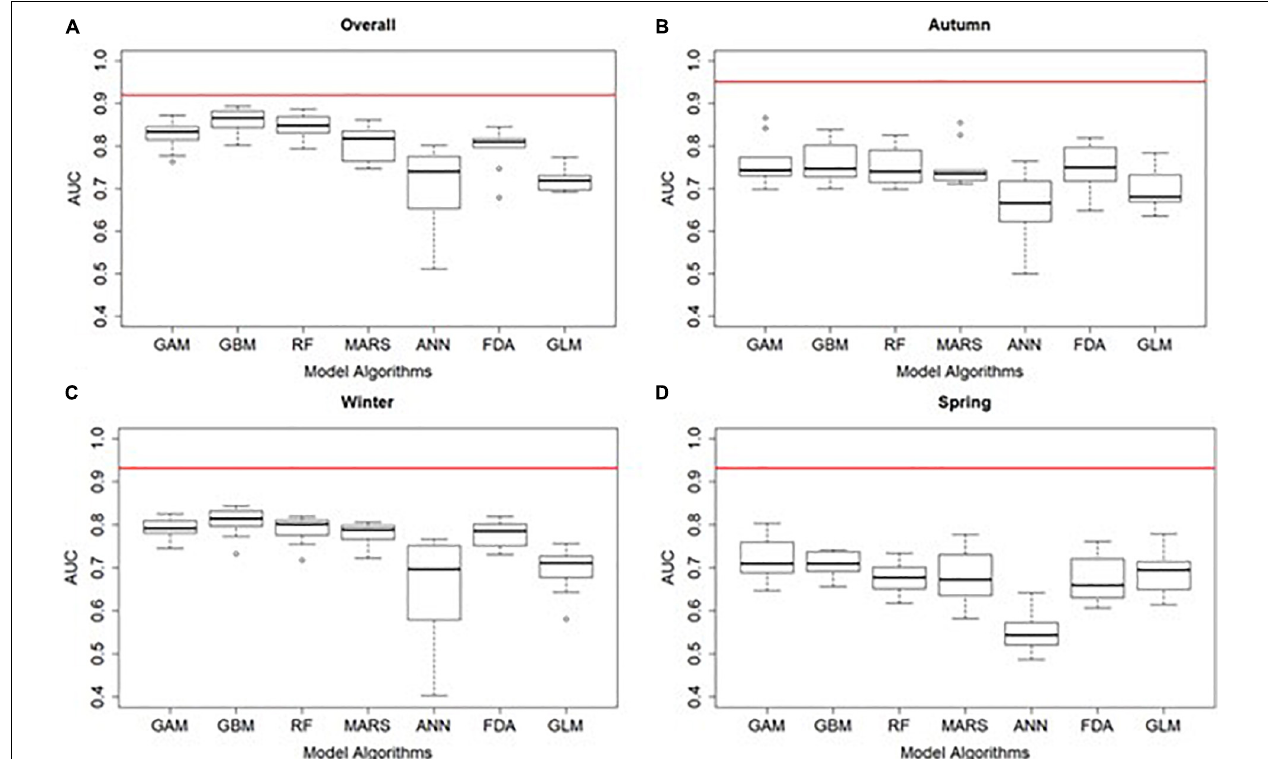
FIGURE 4 | Performance of the overall (A) and seasonal (B–D) species distribution models of Indo-Pacific bottlenose dolphins at the North West Cape, Western Australia. Boxplots for the AUC (area under the curve of the receiver-operating characteristic) of the 10-cross validation runs of each modelling algorithm (GAM, generalised additive model; GBM, generalised boosted model; RF, random forest; MARS, multivariate adaptive regression splines; ANN, artificial neural network; FDA, flexible discriminant analysis; GLM, generalised linear model). The red line shows the AUC of the ensemble model Values of AUC 0.7 indicate that the model predictive performance is moderate to